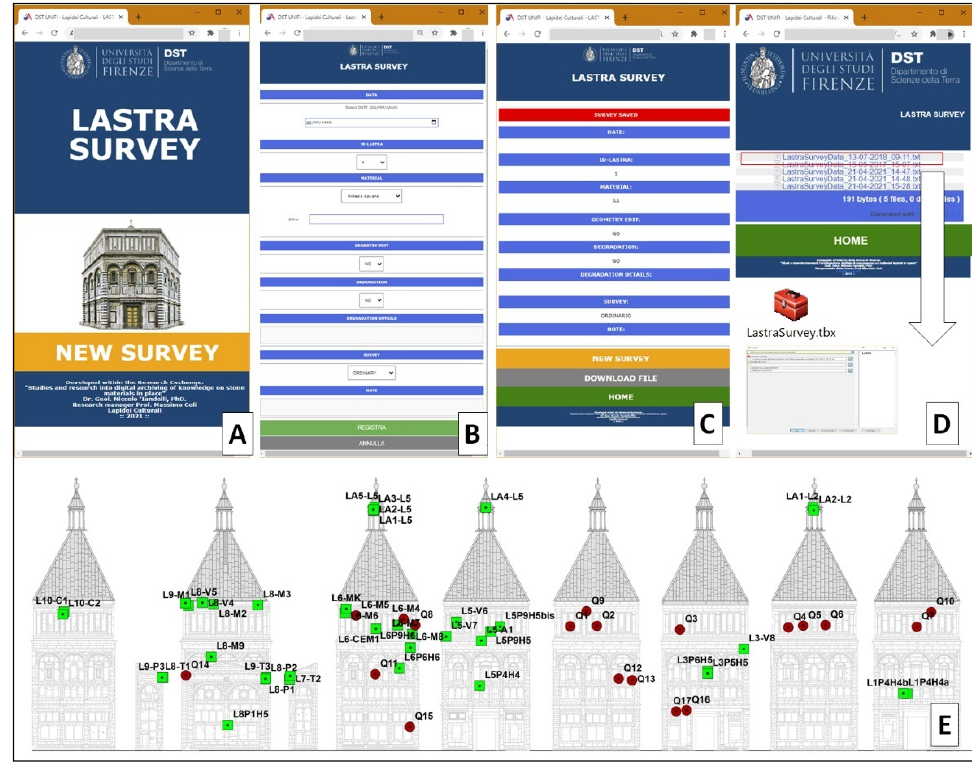
Figure 4. LastraSurvey: ( A ) Home page; ( B ) Data entry page; ( C ) Summary page of the survey; ( D ) Survey Download Page and LastraSurvey Toolbox interface to conversion and styling; ( E ) Mapped reports.